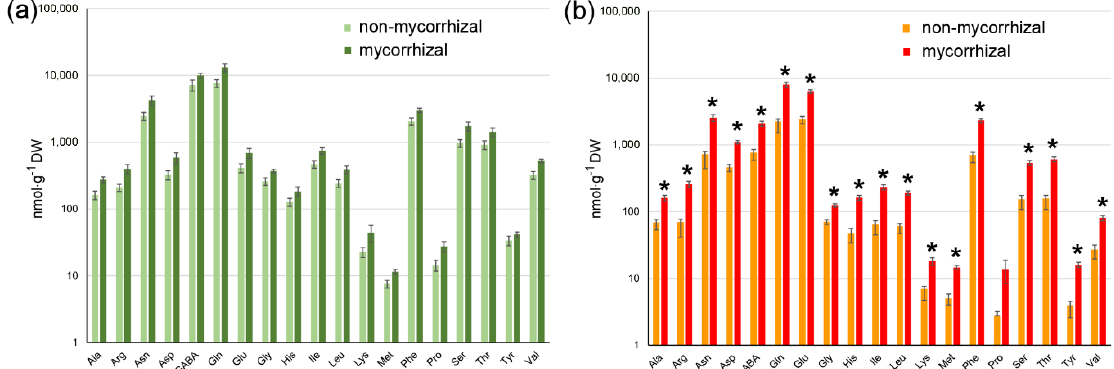
Table 2. Contents of selected carotenoids in fruits from non-mycorrhizal and mycorrhizal plants. Carotenoid 1 Green Fruits